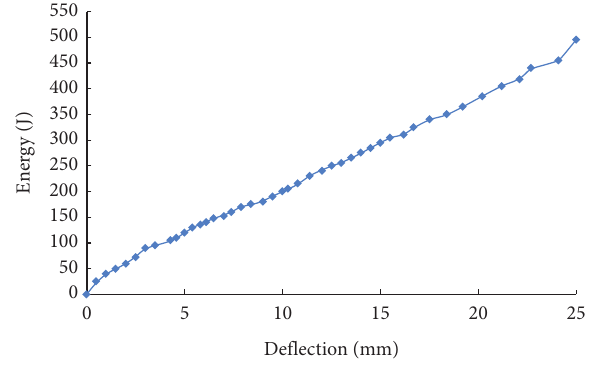
Figure 3: Energy-deflection